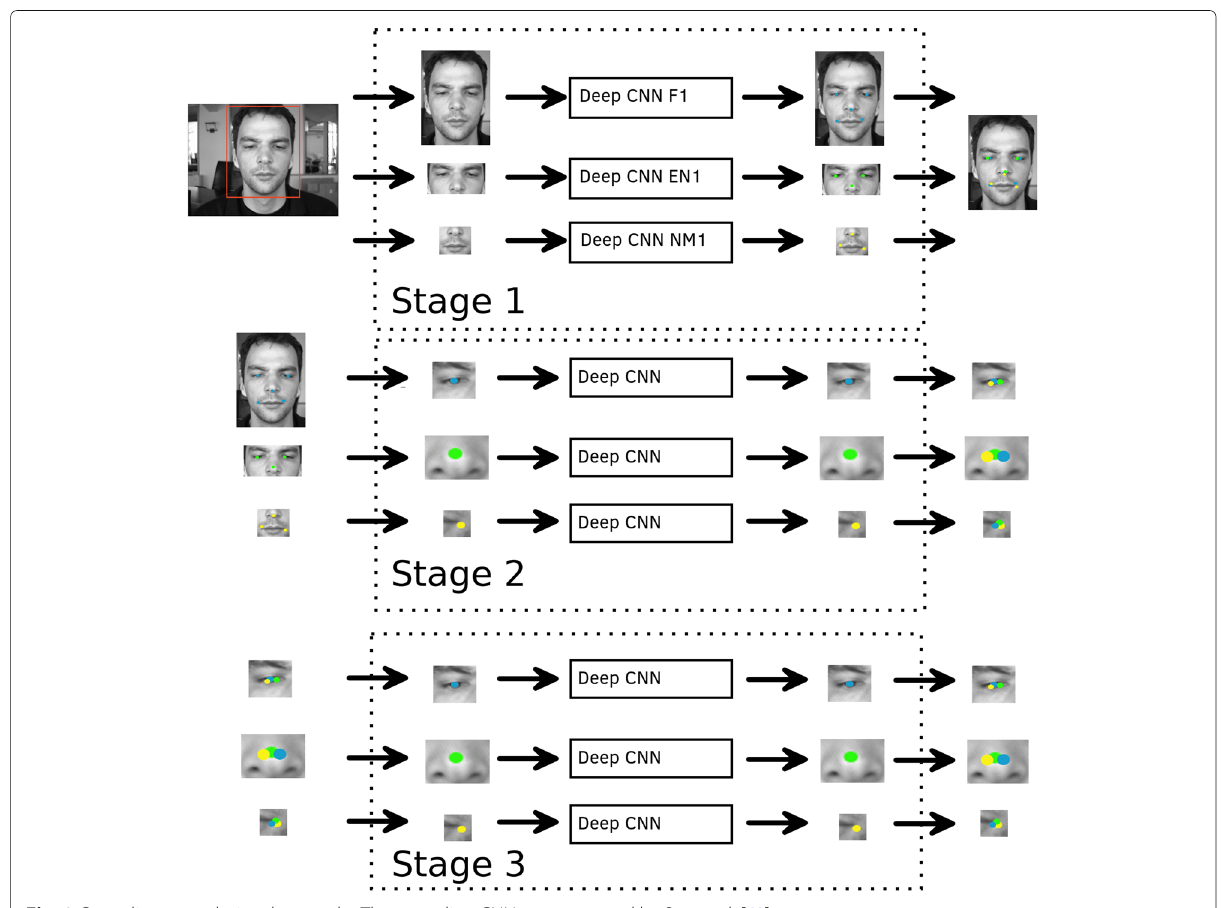
Fig. 8 Cascading convolutional networks. The cascading CNN structure used by Sun et al. [62]